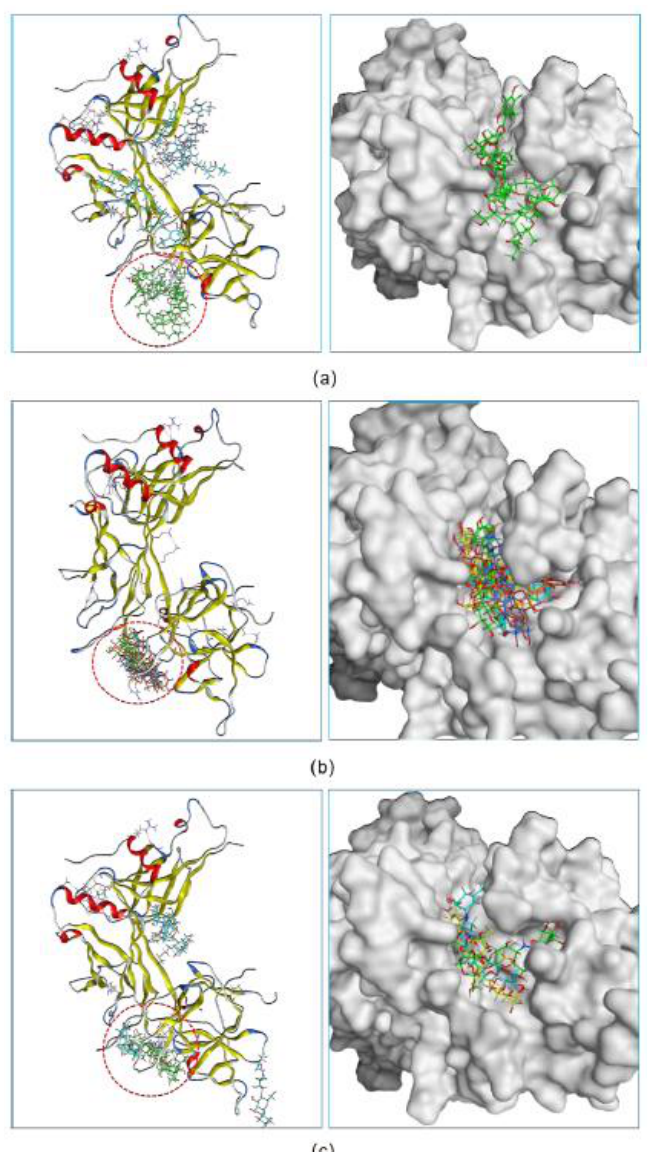
Figure 2. The inhibitory abilities of three hits were investigated in a docking experiment. Three fidaxomicin molecules ( a ), or four schaftoside molecules ( b ), or three acarbose molecules ( c ) could strictly occupy the active site of RBPJ that is indicated by a red dashed circle.